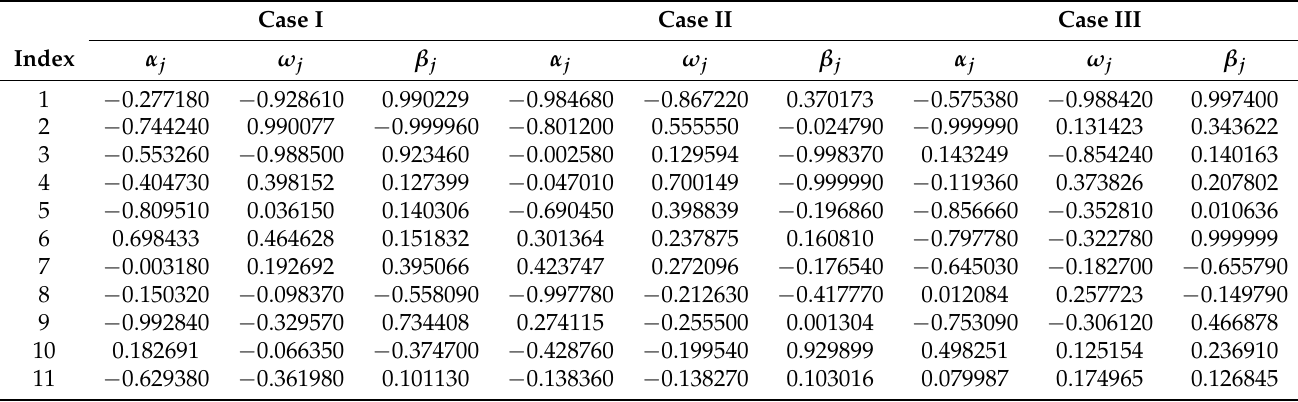
Table 8. Best set of weights obtained by the LNN-GNDO-SQP algorithm using a fitness function as in Equation (53). Here three cases are studied by varying W e in the drainage problem.